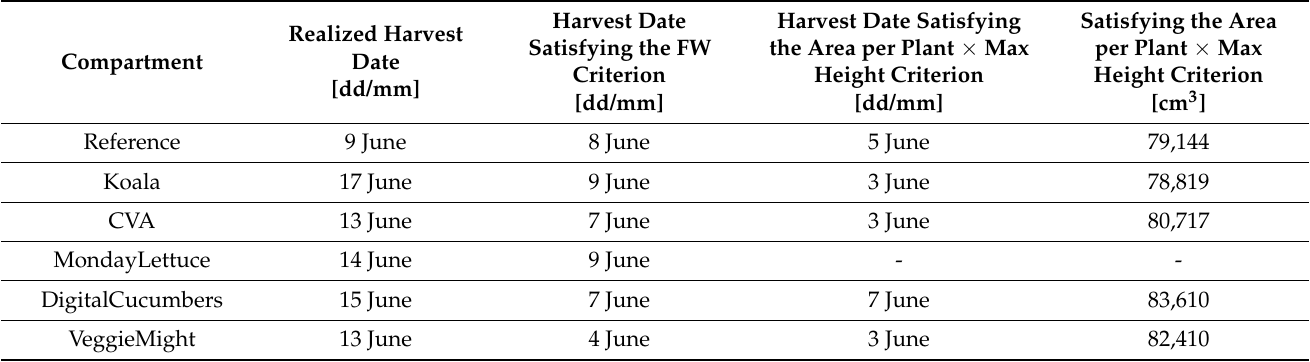
Table 4. Overview of area per plant multiplied by max height criterion at optimal harvest date (when harvest indicator is 7840 cm 3 per lettuce head is